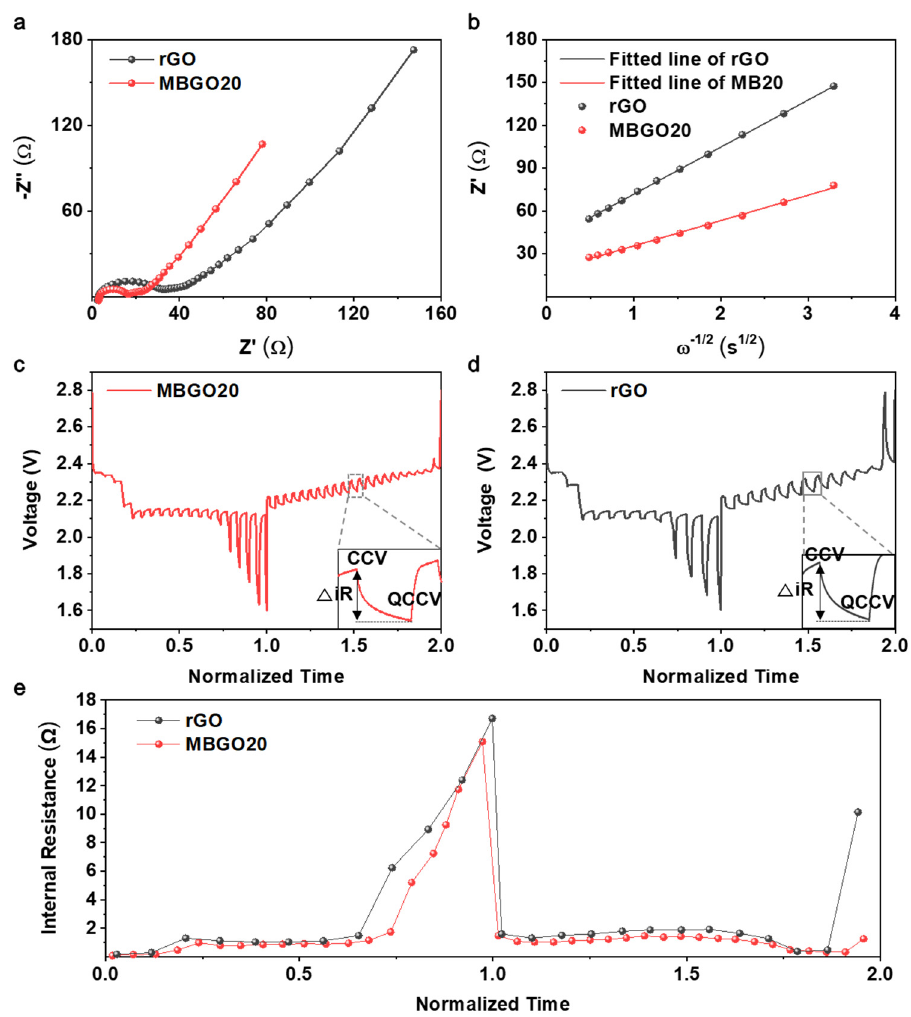
Figure 4. ( a ) Nyquist plots of MBGO20 and rGO cathodes. ( b ) Relationship between Z’ and ω − 1/2 in the low-frequency region. GITT curves of ( c ) MBGO20 and ( d ) rGO cathode at 0.02 C. ( e ) Internal resistance based on GITT.